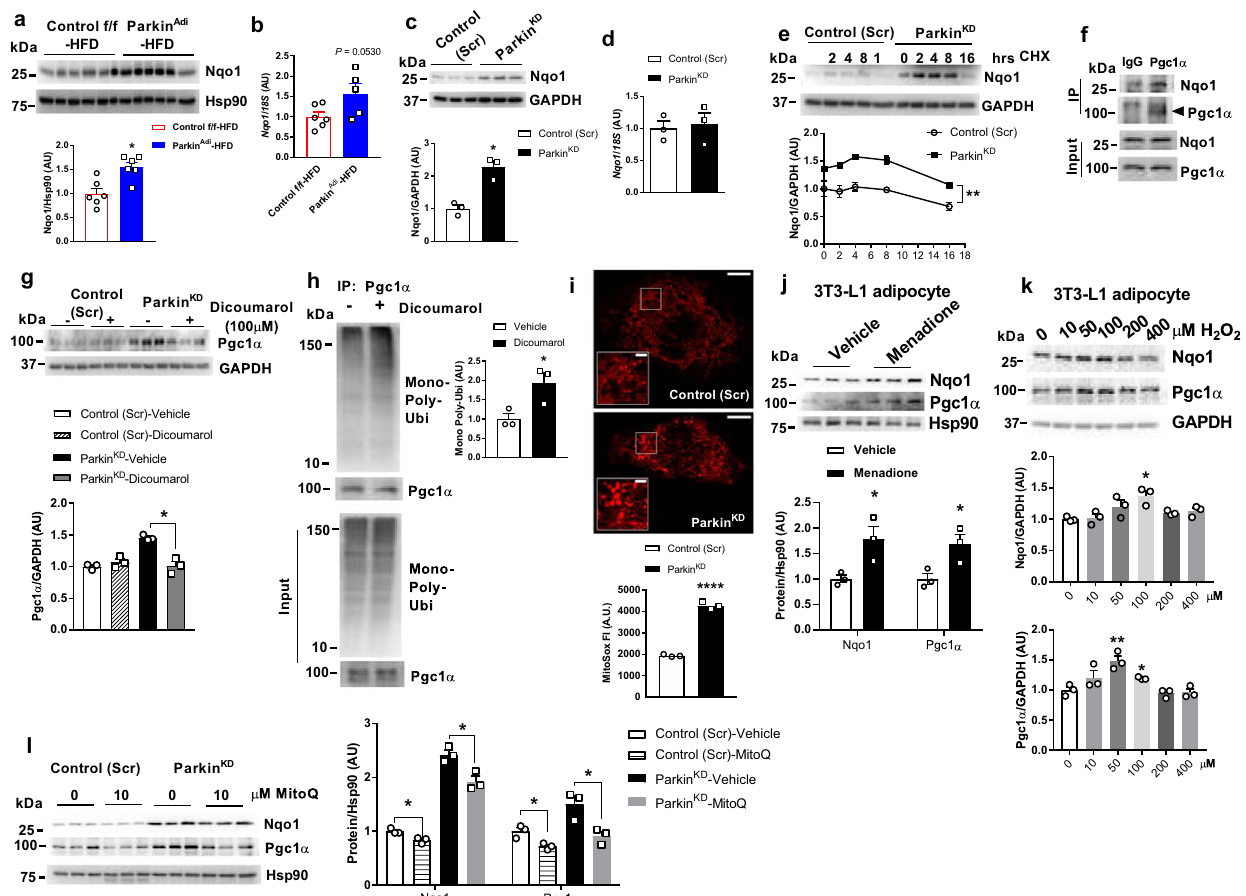
Fig. 5 | Adipose-speci fi c Parkin deletion enhances Pgc1 α protein stability by elevating Nqo1. a , c Western blot and densitometry analysis of Nqo1 in eWAT of Control f/f and Parkin Adi mice fed with HFD (normalized to Hsp90; n =6 mice for eachgenotype)andindifferentiatedadipocytesofControl(Scr)andParkin KD ( n =3 biological replicate; normalized to GAPDH) [Unpaired Student ’ s t test two-tailed. For Control f/f-HFD vs. Parkin Adi -HFD, p =0.0040, 95%CI=0.2219 – 0.8880, R squared=0.5795; for Control (Scr) vs. Parkin KD , p =0.0049, 95%CI=0.6432 – 1.893, R squared=0.8881]. b , d mRNA level of Nqo1 in eWAT of Control f/f and Parkin Adi mice fed with HFD ( n =6 mice for each genotype, except one sample in Parkin Adi -HFD group with undetectable Nqo1 gene expression) and in differentiated adi- pocytesofControl(Scr)andParkin KD ( n =3biologicalreplicate). e Westernblotand densitometry analysis of Nqo1 (normalized to GAPDH) in the differentiated 3T3-L1 Control (Scr)and Parkin KD adipocytes treatedwith 100 μ g/ml CHXatthe indicated time. ( n =3 biological replicate) [Two-way ANOVA F (1,4)=60.63, p =0.0015, 95% CI= − 0.6296 to − 0.2986]. f Co-immunoprecipitation analysis of Pgc1 α and Nqo1 in thelysatesofeWATfromWTmice( n =1). g Westernblotanddensitometryanalysis of Pgc1 α (normalized to GAPDH) in the differentiated 3T3-L1 Control (Scr) and Parkin KD adipocytes treated with vehicle and Dicomarol (Nqo1 inhibitor) ( n =3 biological replicate) [Unpaired Student ’ s t test two-tailed. For Parkin KD -vehicle vs. Parkin KD -Dicoumarol, p =0.0041, 95%CI= − 0.6501 to − 0.2355, R squared=0.8979]. h Co-immunoprecipitation of Pgc1 α in differentiated 3T3-L1 Control (Scr) and Parkin KD adipocytes treated with vehicle or Dicoumarol ( n =3 biological replicate) [Unpaired Student ’ s t test two-tailed. For vehicle vs. Dicoumarol, p =0.0379, 95% CI=0.08481 – 1.780, R squared=0.6999]. i Images of MitoSox staining and